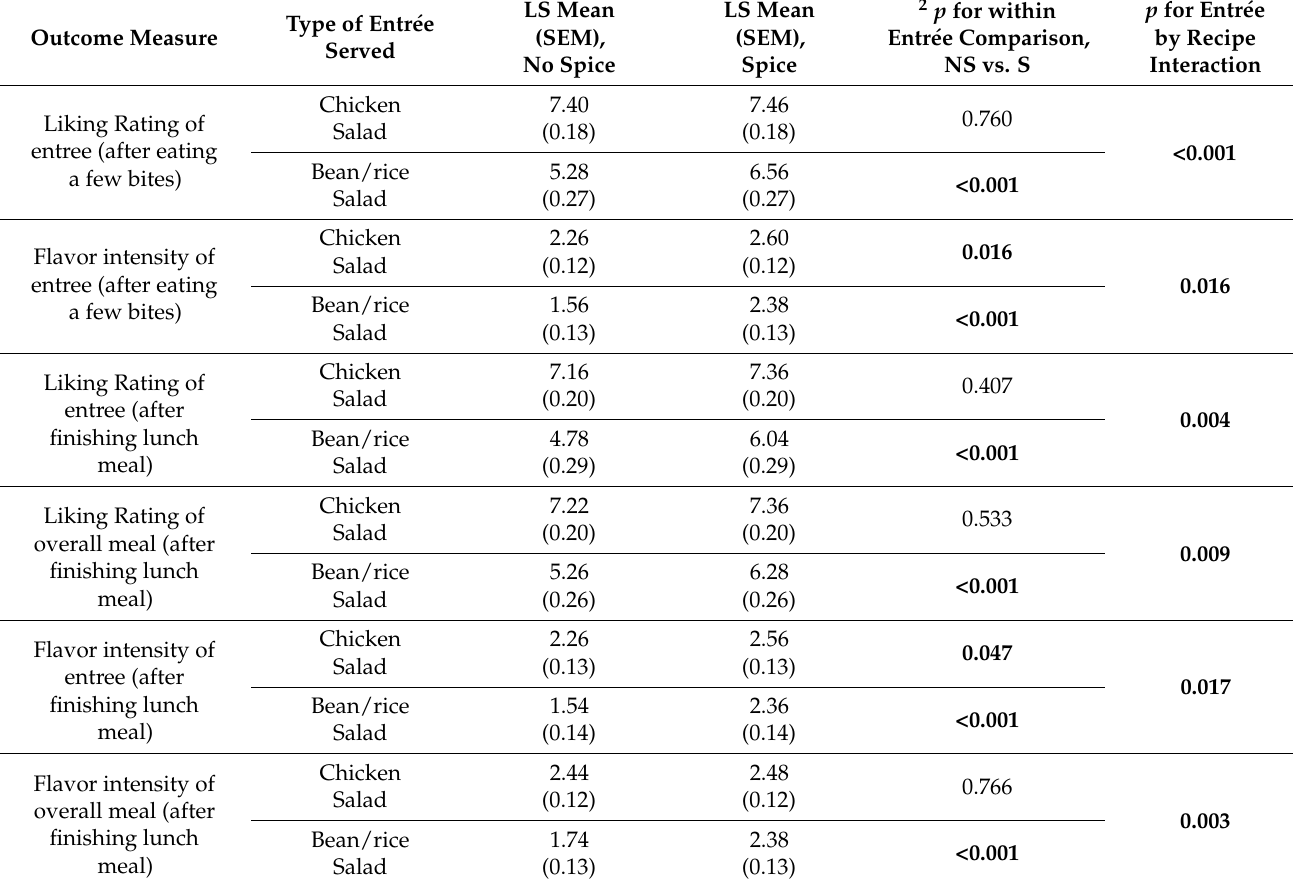
Table 3. 1 Liking and Flavor Intensity